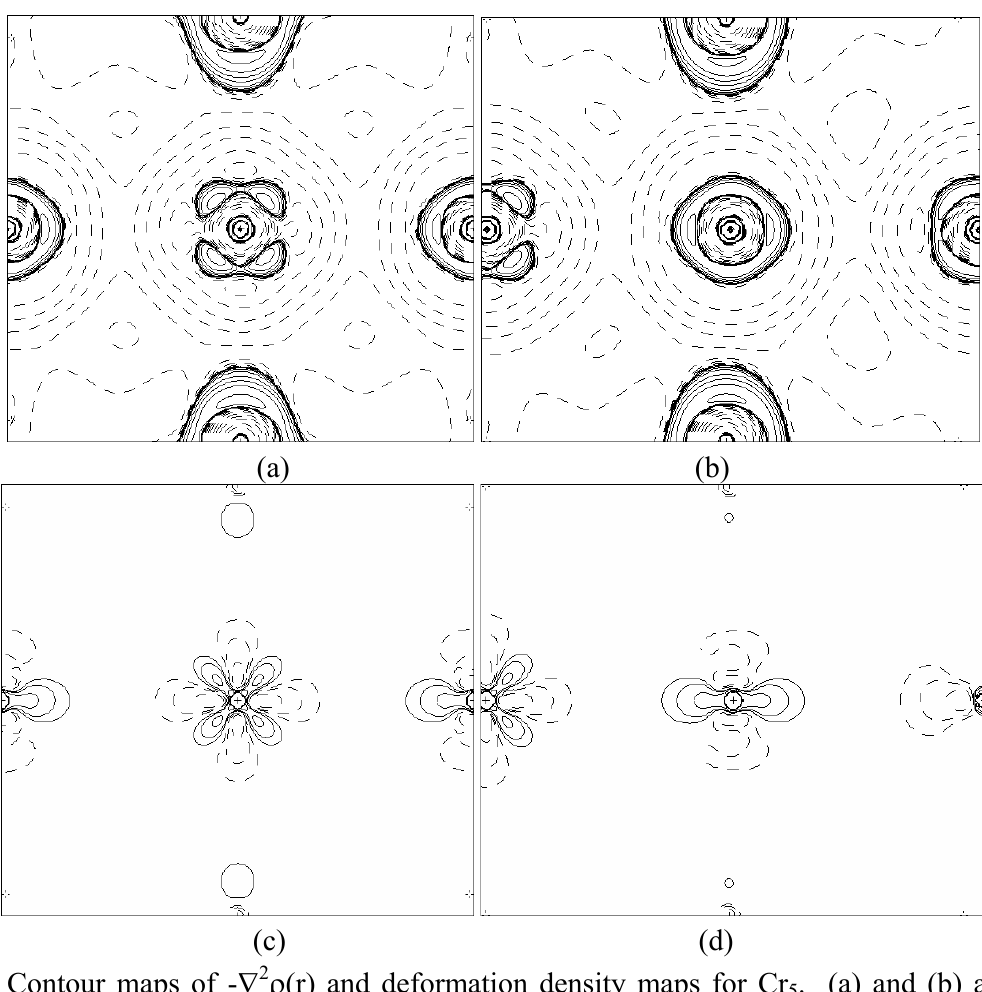
Figure 5 Contour maps of - ∇ 2 ρ (r) and deformation density maps for Cr maps of - ∇ 2 ρ (r) with Cr(1) and Cr(2) as the center respectively. (c) and (d) are the corresponding deformation density maps. The rest are the same as those found in Figure